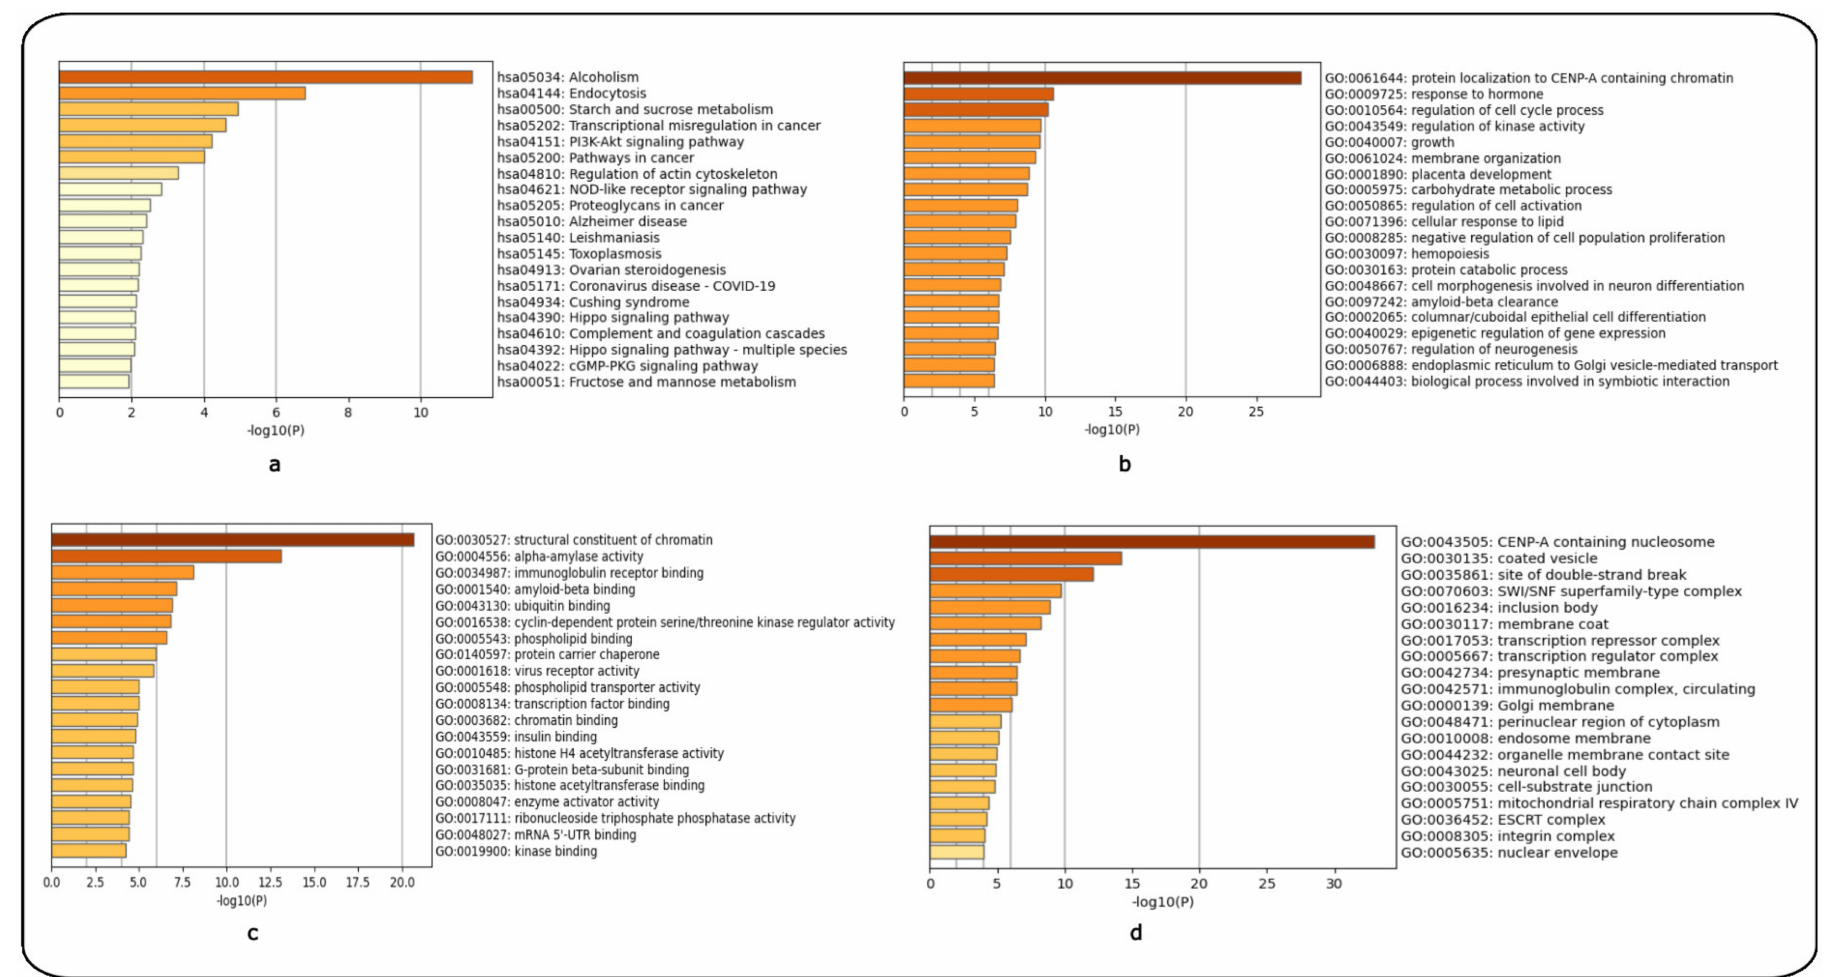
Figure 4. Enrichment analysis of controls versus symptomatic HD patients using the KEGG and GO libraries in Metascape. ( a ) KEGG pathways, ( b ) GO Biological Process, ( c ) GO Molecular Function and ( d ) GO Cellular